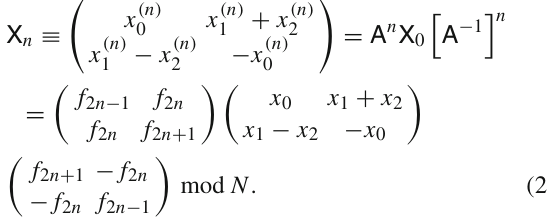
Thus T ( N ) is, also, the period of the Fibonacci sequence mod N , which is well known to be a “random” function of N ; cf. Fig.